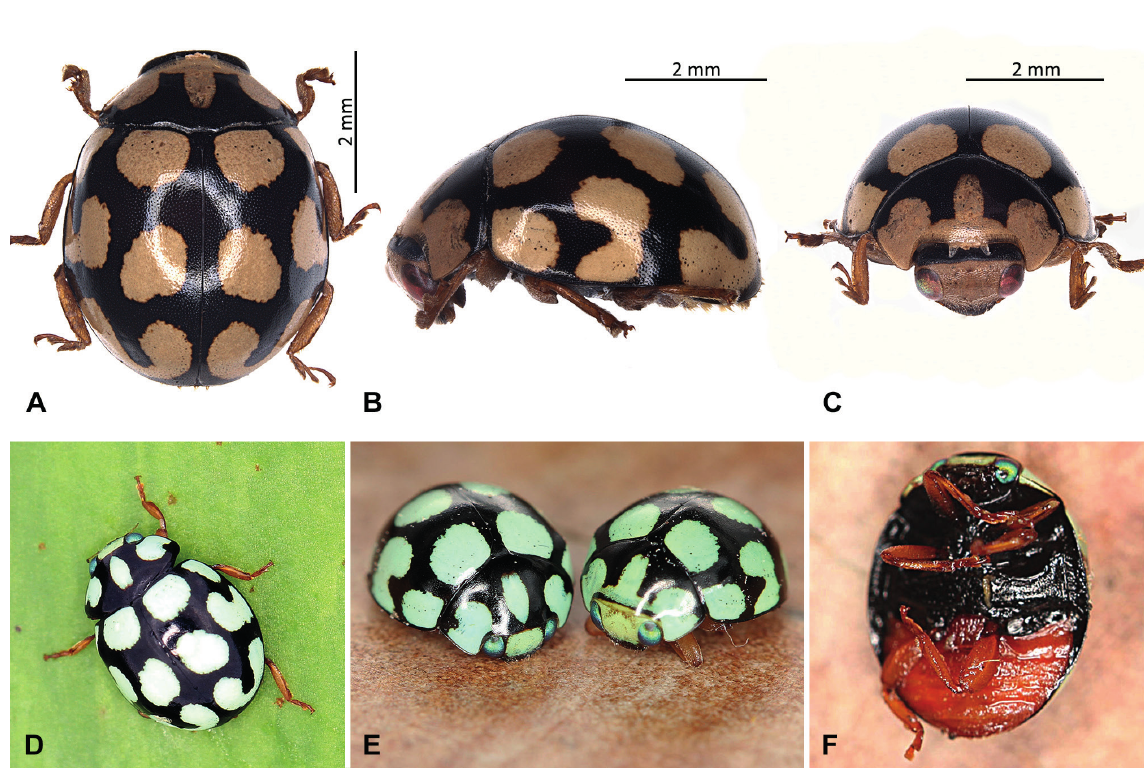
Fig. 1. Habitus of Cyrea mcclarini sp. nov. A . Paratype (MIZ), ♂, dorsal view. B . Paratype (MIZ), ♂, lateral view. C . Paratype (MIZ), ♂, frontal view. D . Living specimen, dorsal view. E . Living specimens (left = female; right = male). F . Living specimen, ventral view. Photos: D–F = Jim